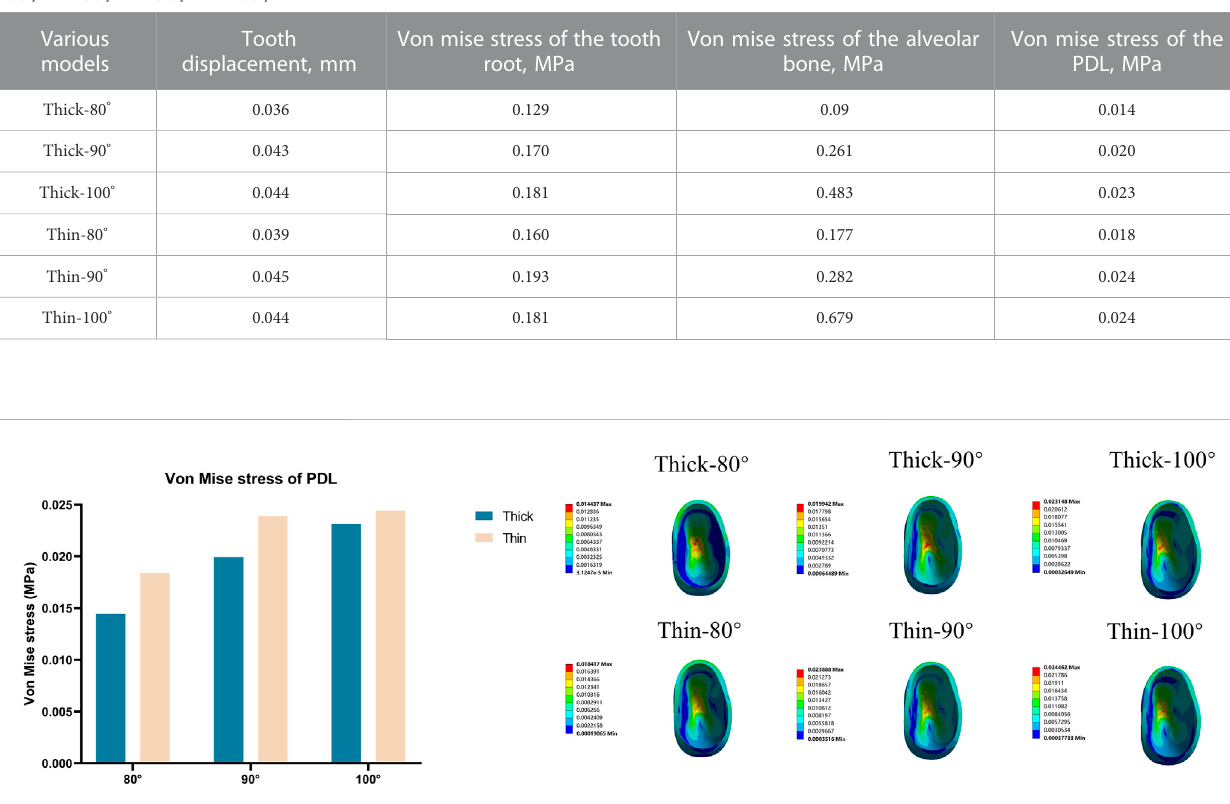
FIGURE 3 Von Mise stress on the PDL of the central incisor in various models (Thick-80 ° ; Thick-90 ° ; Thick-100 ° ; Thin-80 ° ; Thin-90 ° ; Thin-100 °